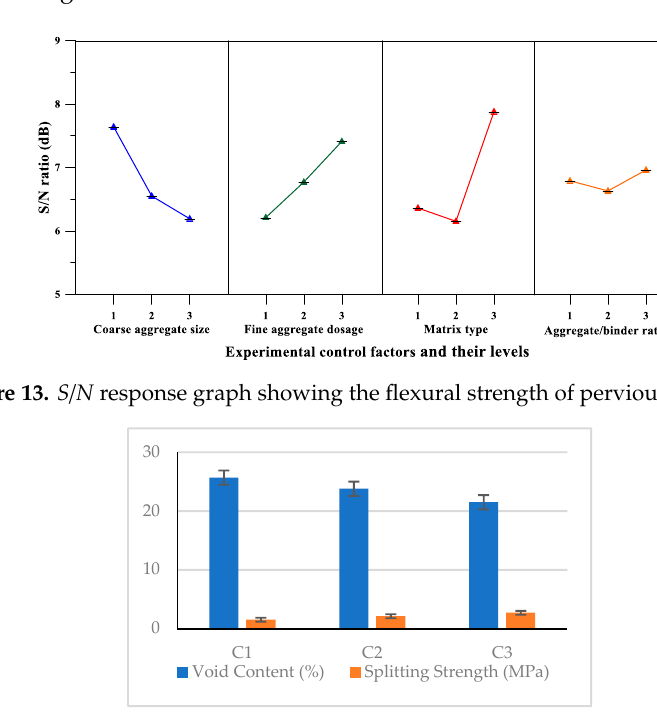
Figure 14. Relationship between splitting strength and void content.